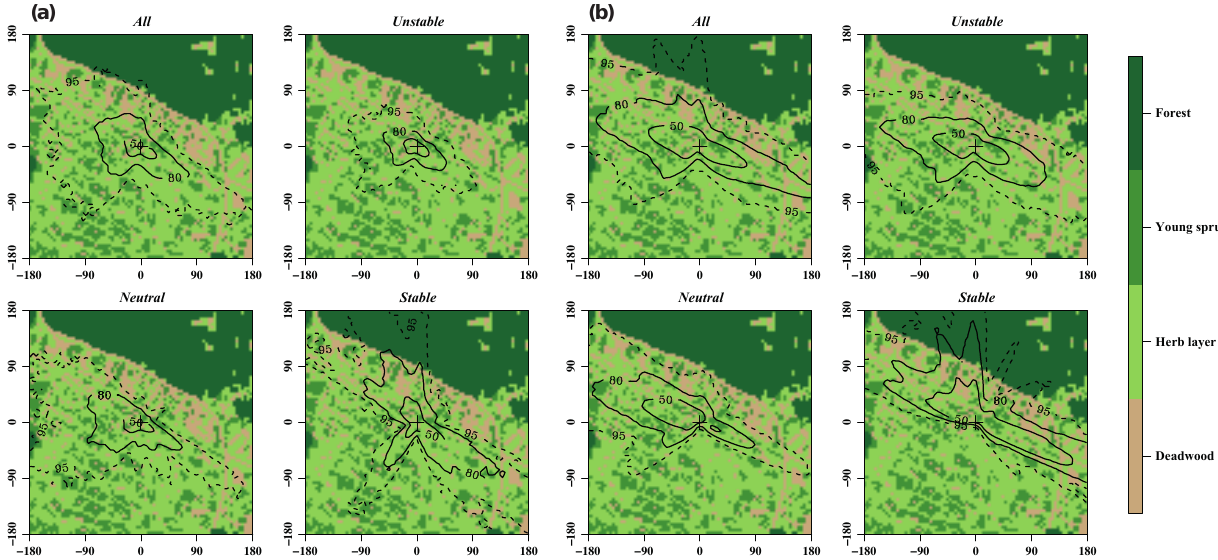
Figure 2. Footprint climatology of the Köhlerloh clearing (26 June to 17 July 2011) at the turbulence mast (TM) for the three stability classes and the combination of all classes; (a) left four panels at a 2.25m measuring height; (b) right four panels at a 5.5m measuring height. Here, four different land use classes are considered, with the herb layer being composed of Deschampsia , Calamagrostis , Juncus , and Vaccinium . Distances are given in meters.